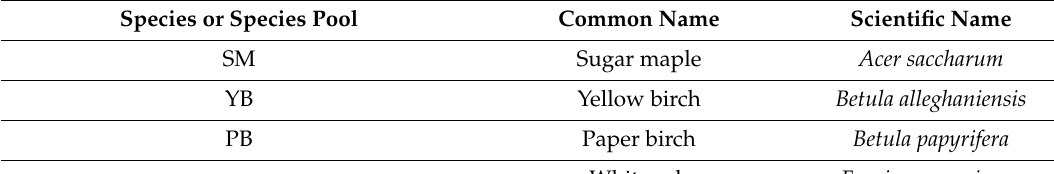
Table 1. Tree and shrub species reported in the regeneration surveys across the study sites, as well as the species pools used in the analyses. Some species do not appear in this table because they were too